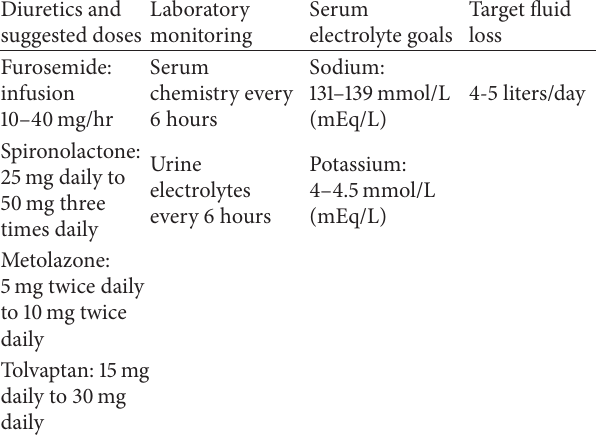
Table 1: Diuretics’ protocol: doses of furosemide and metolazone weretitratedbasedonurineoutput;spironolactonedosewastitrated to maintain a serum potassium of 4–4.5 mmol/L (mEq/L); tolvaptan dose was titrated to maintain a serum sodium of 131–139mmol/L (mEq/L) (based on the initial value, maximum correction was 6– 8 mmol/L (mEq/L) and not to exceed 139mmol/L (mEq/L) in 24